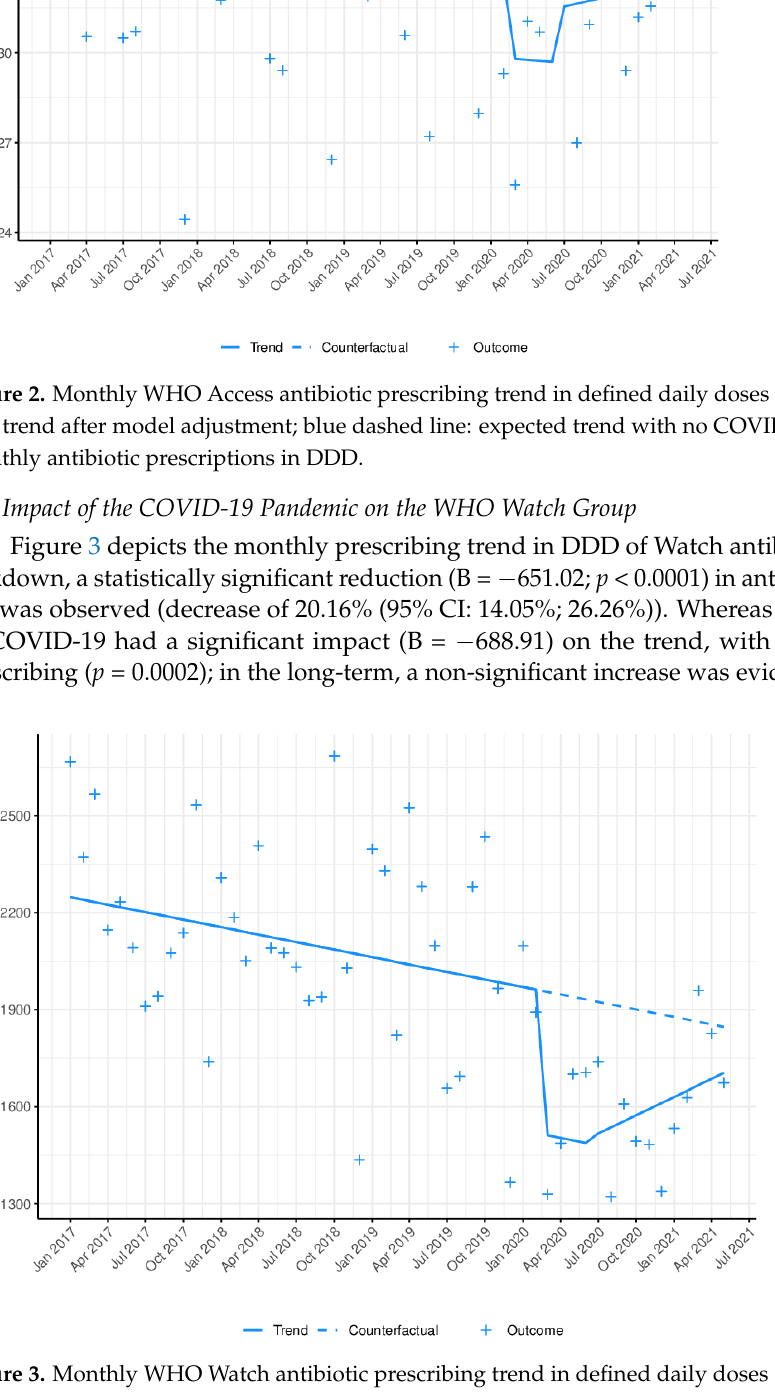
Figure 3 . Monthly WHO Watch antibiotic prescribing trend in defined daily doses (DDD). Blue line ( − ): trend, after model adjustment; blue dashed line: expected trend with no COVID-19 outbreak; +: monthly antibiotic prescriptions in DDD.